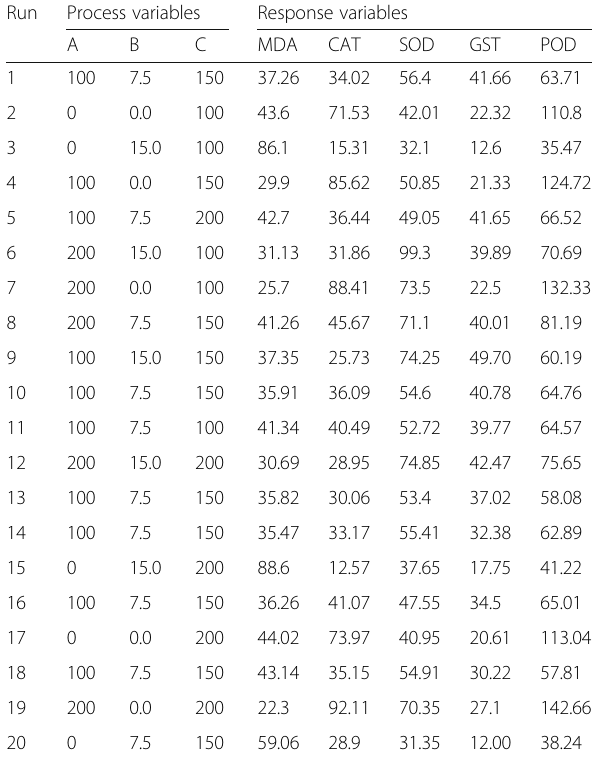
Table 2 Experimental RSM-CCD and results of responses from the present study Run Process variables